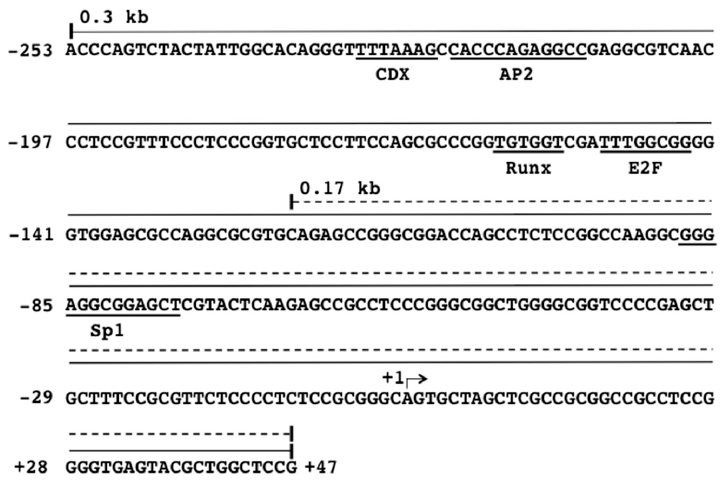
Figure 1. The nucleotide sequence of the human β 4GalT4 gene promoter with transcription factor binding sites. The transcriptional start site is indicated with arrow. The numbers show the nucleotide positions from the transcriptional start site (+1). The reporter plasmids, pGL4-0.3 and pGL4-0.17, were prepared by insertion of the 0.3 kb and 0.17 kb promoter regions into the pGL4.15[luc2p/Hygro] vector, respectively.